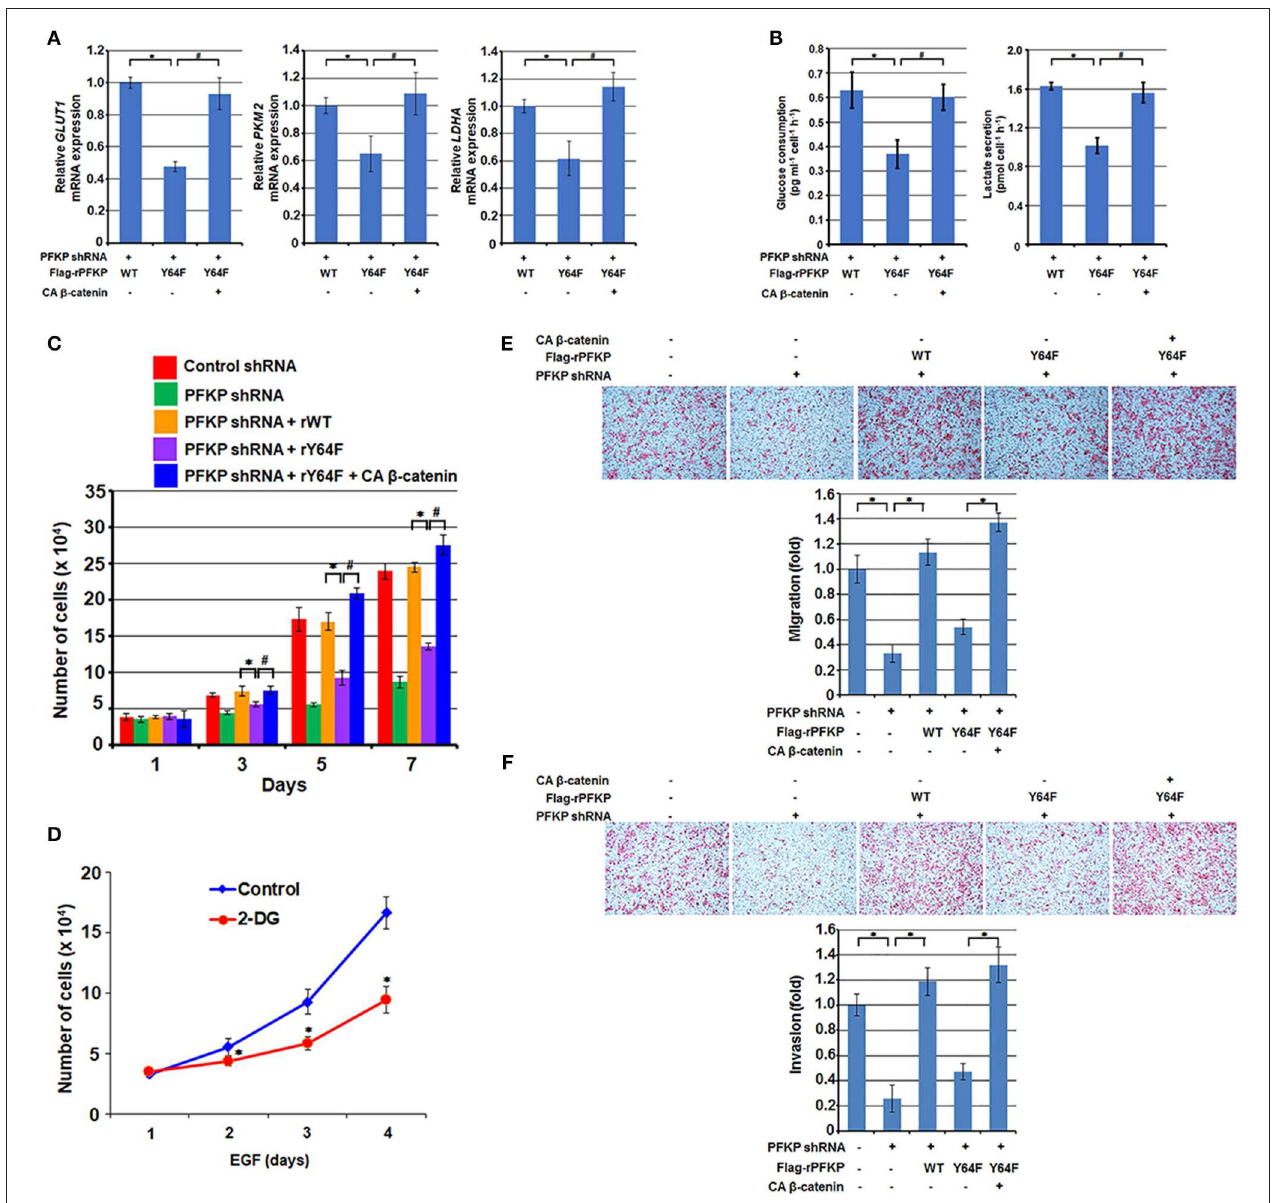
FIGURE 3 | PFKP Y64 phosphorylation promotes EGFR activation-induced GBM cell glycolysis, proliferation, migration, and invasion. (A,B) Endogenous PFKP-depleted U87/EGFRvIII cells with reconstituted expression of WT Flag-rPFKP or Flag-rPFKP Y64F mutant in the presence or absence of CA β -catenin expression were cultured in no-serum DMEM for 24h. The media were collected for analysis of glucose consumption (A) or lactate production (B) . All results were normalized to the final cell number. Data represent the means ± SD of three independent experiments. * P < 0.001, # P < 0.001, based on the one-way ANOVA. (C) U87/EGFRvIII cells with or without PFKP depletion and with or without reconstituted expression of WT Flag-rPFKP or Flag-rPFKP Y64F mutant in the presence or absence of CA β -catenin expression were cultured in 1% serum medium for the indicated periods of time and were harvested for cell counting. Data represent the means ± SD of three independent experiments. * P < 0.001, # P < 0.001, based on the one-way ANOVA. (D) U251 cells were pretreated with DMSO (Control) or 2-DG (10mM) for 2h and then the cells were treated with or without EGF (100ng/ml) for the indicated periods of time. The cell numbers were counted. Data represent the means ± SD of three independent experiments. * P < 0.001, based on the Student’s t -test. (E,F) U87/EGFRvIII cells with or without PFKP depletion and with or without reconstituted expression of WT Flag-rPFKP or Flag-rPFKP Y64F mutant in the presence or absence of CA β -catenin expression were placed in serum-free medium in the upper transwell chamber or Matrigel-coated transwell chamber for migration (E) or invasion (F) assays, respectively. Six hours (migration assay) or twenty-four hours (invasion assay) after plating, cells that migrated to the opposite side of the insert were fixed with methanol and stained with hematoxylin and eosin. Representative microphotographs are shown (left panels). Stained cells were counted under a microscope (right panels). Data represent the means ± SD of three independent experiments. * P < 0.001, based on the one-way ANOVA.